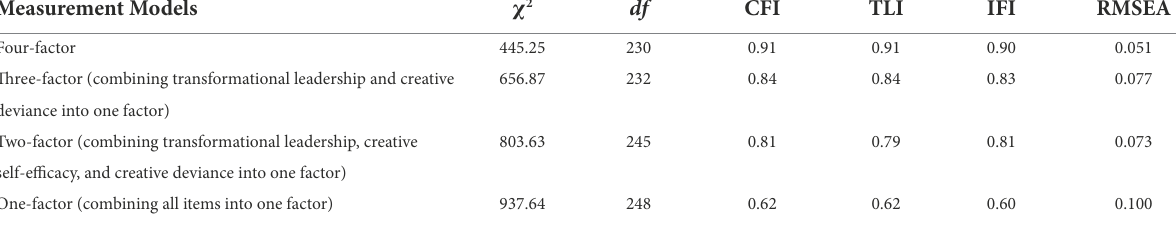
TABLE 1 Confirmatory factor